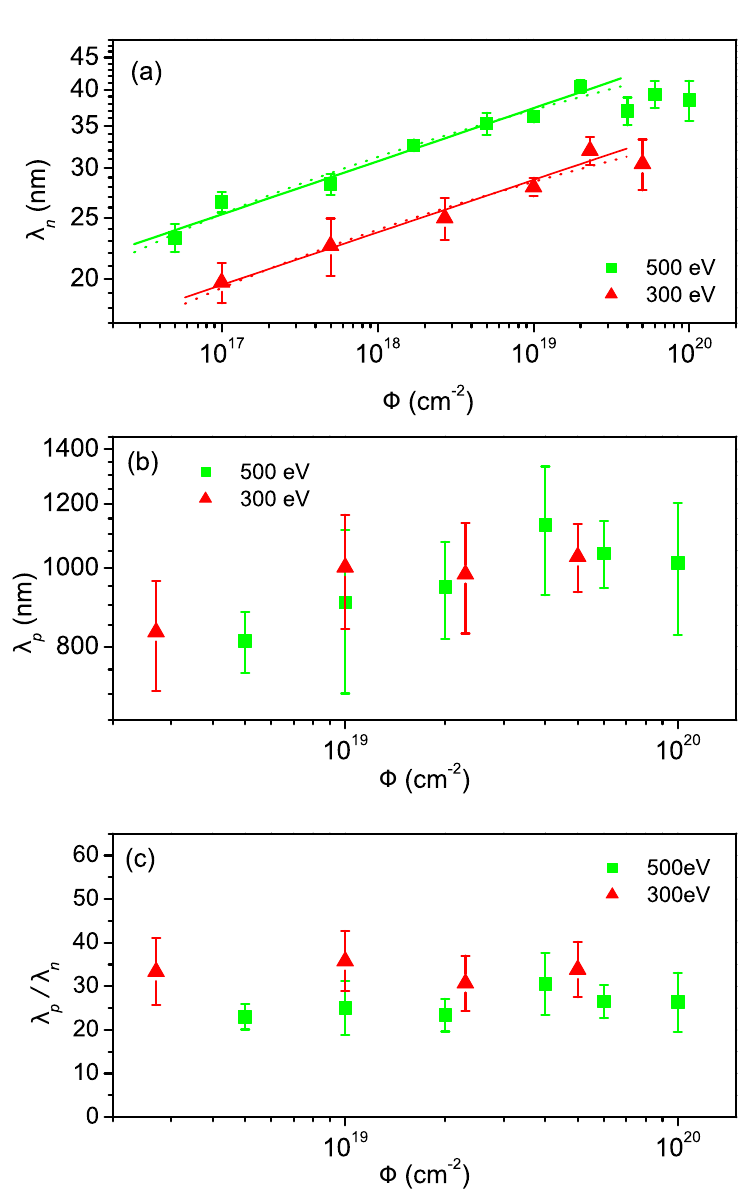
Figure 7. Evolution of (a) normal wavelength λ of parallel to normal periodicity λ in (a) represent power law fits, yielding coarsening exponents of n = 0 . 085 ± 0.006 and n = 0 . 084 ± 0.007 for 500 eV and 300 eV, respectively. The dotted lines represent logarithmic fits